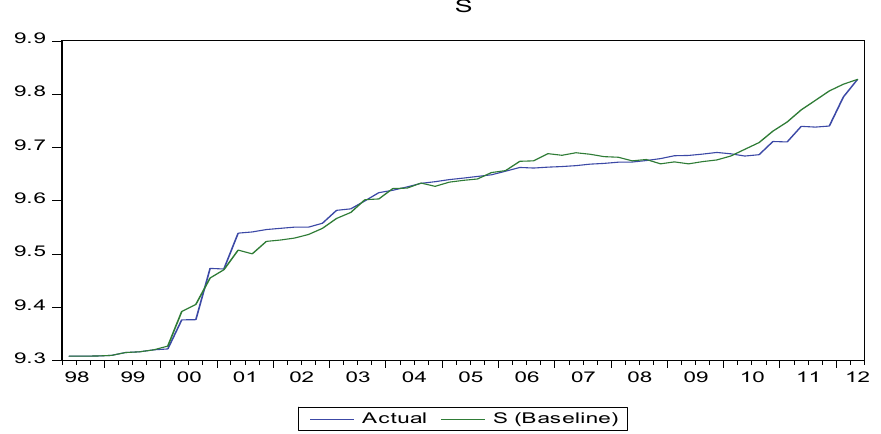
Fig. 1. Actual and Forecasted values of Vietnamese dong-US dollar exchange